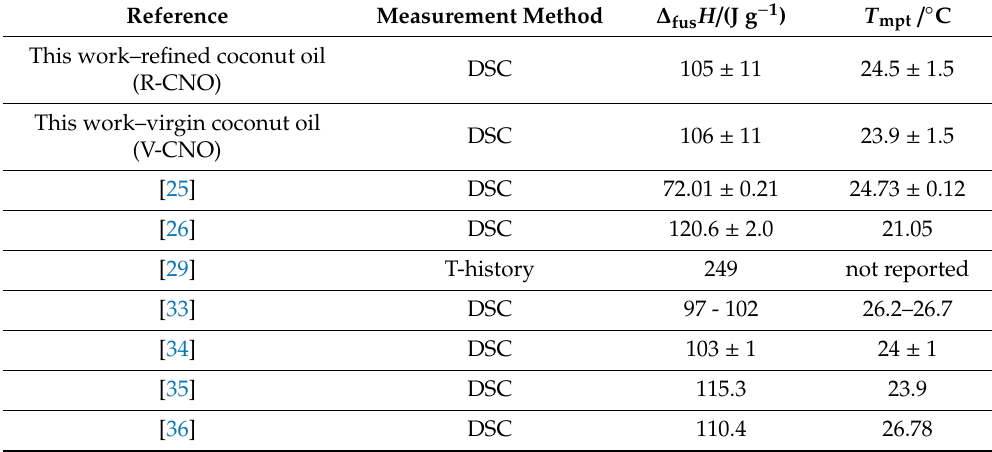
Figure 3. DSC thermograms of ( a ) refined coconut oil (R-CNO) and ( b ) virgin coconut oil (V-CNO) measured at 10 K / min for Cycle 1 (first melt of a fresh sample) and after 5, 100, and 200 melt-freeze cycles. For both R-CNO and V-CNO, the widths of the endothermic (melting) and the shapes of the exothermic (solidification) peaks changed slightly after cycling but values of ∆ fus H and T mpt derived from the endothermic peaks of all cycles remain within the uncertainty of the measurements. ( c ) Regardless of the number of thermal cycles, the first melt DSC curve for each coconut oil sample featured a main peak and a shoulder peak that merged into a single peak in the subsequent melting curves (see also Figure S5 of Supplementary Materials). Table 2. Values of the latent heat of fusion, ∆ fus H , and melting temperature, T mpt , of coconut oil Table 2. Values of the latent heat of fusion, Δ fus H , and melting temperature, T mpt , of coconut oil determined in this work and as reported in the determined in this work and as reported in the literature.